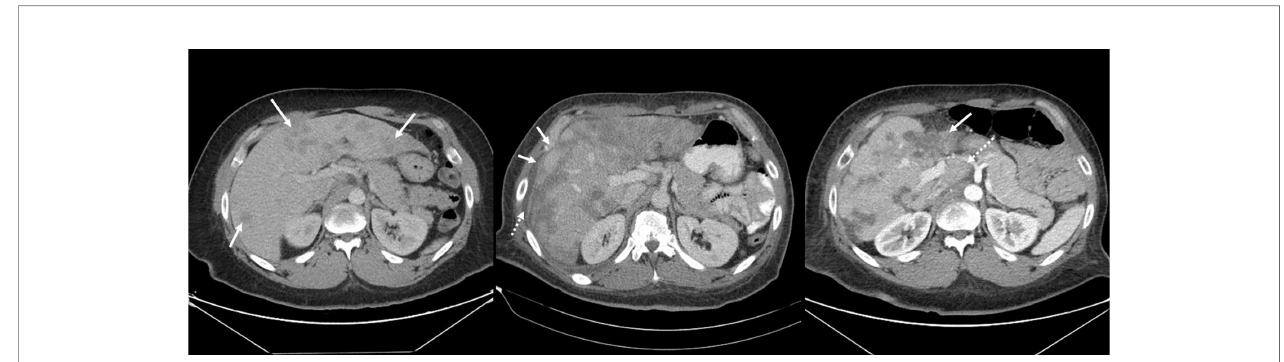
FIGURE 2 | Serial contrast enhanced CT images of the abdomen in the axial plane showing evolution of pseudocirrhosis in a patient with breast cancer and liver metastases. (A) Baseline image shows multiple liver metastases (arrows); (B) At 6 months follow up, the lesions became larger and more con fl uent and the hepatic contour started to become nodular (solid arrows). A small volume of perihepatic ascites started to accumulate (dashed arrow). (C) At 13 months, there was signi fi cant atrophy of the left lobe (solid arrow) and hypertrophy of the caudate lobe (dashed arrow).